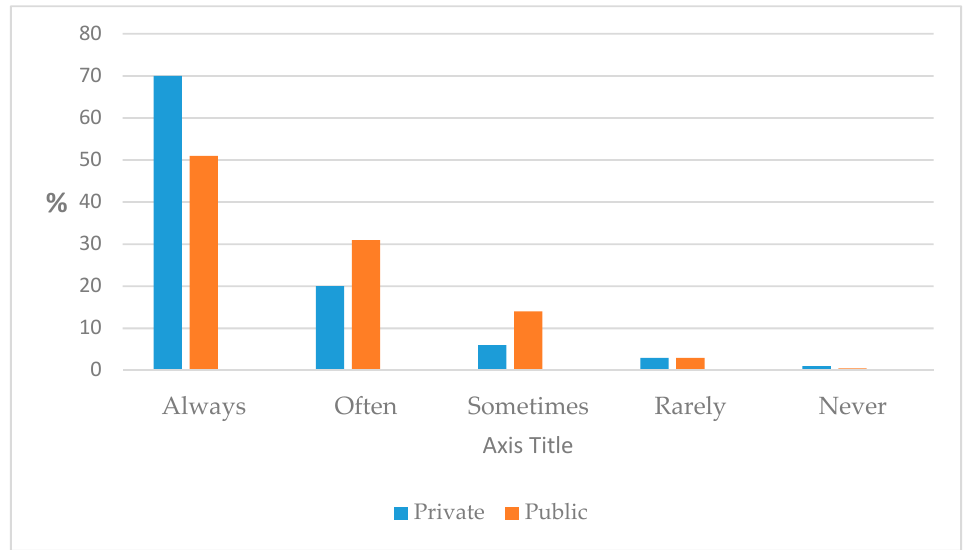
Figure 1. Proportion of public-and private-sector workers sitting for periods of over 30 min during work.